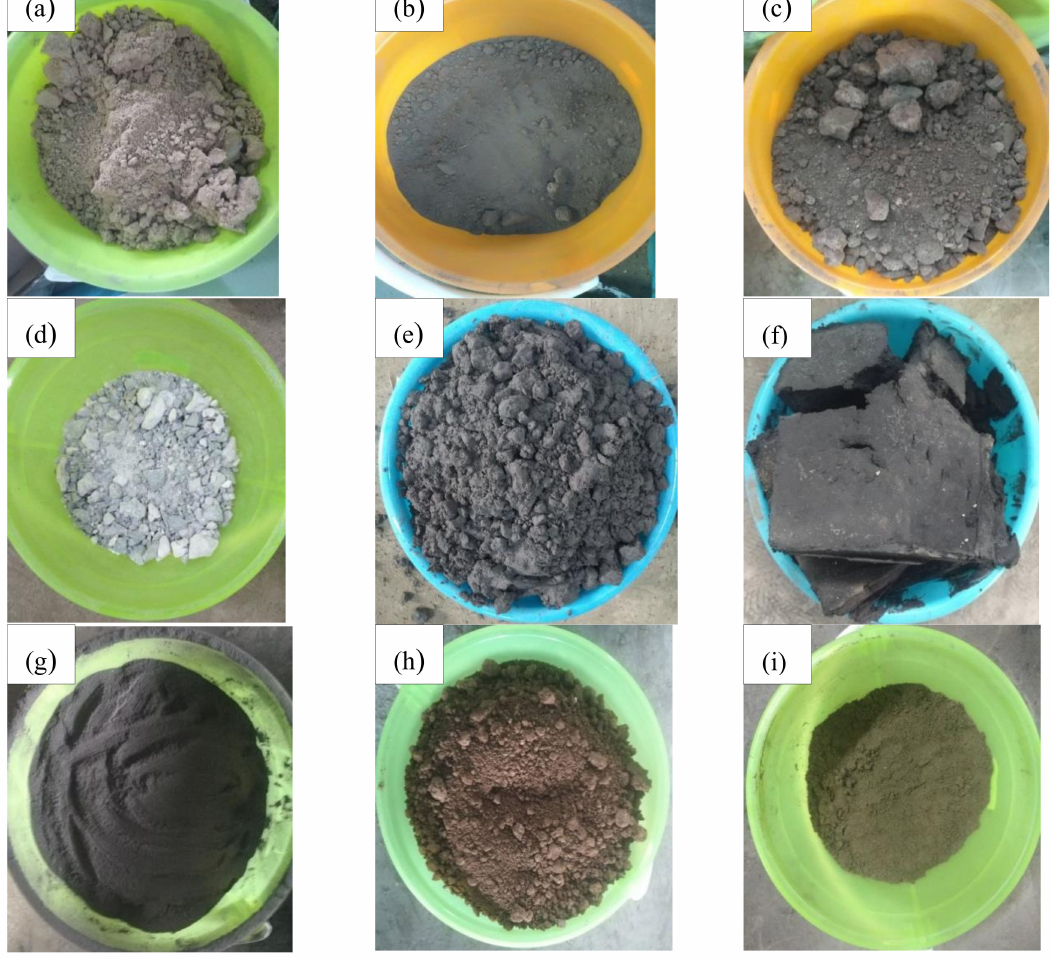
Figure 3. Physical aspect of each filler. ( a ) desulfurized gypsum; ( b ) fly ash; ( c ) red mud; ( d ) mercury slag; ( e ) lead-zinc slag; ( f ) manganese slag; ( g ) silica fume; ( h ) clay and ( i )